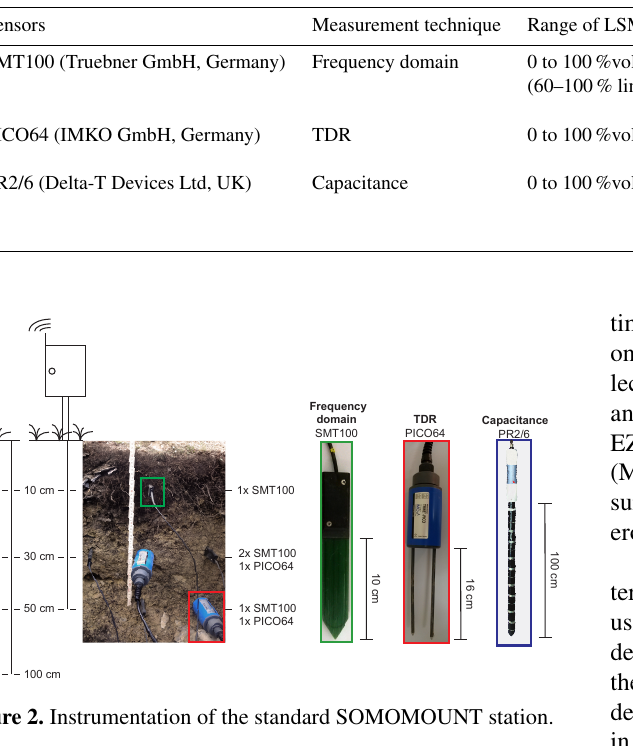
Figure 1. Map of Switzerland showing the location of the soil moisture monitoring stations from the SOMOMOUNT and SwissSMEX project (Mittelbach and Seneviratne, 2012) as well as the ARPA monitoring station Cervinia (Pogliotti et al., 2015). Selected mountain weather stations form the SwissMetNet network used in Sect. 5.2 are also displayed. Table 1. Characteristics of the three types of soil moisture sensors used in the SOMOMOUNT network. All values in the table are provided by the manufacturers (Delta-T Devices, 2008; IMKO, 2015; Truebner, 2016).